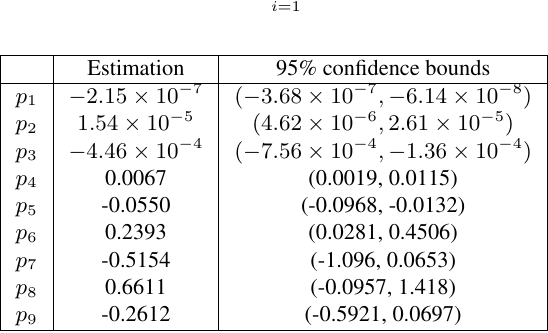
Table 2. Experiment parameters in Distance Clarity function Plot the function of F e likewise.